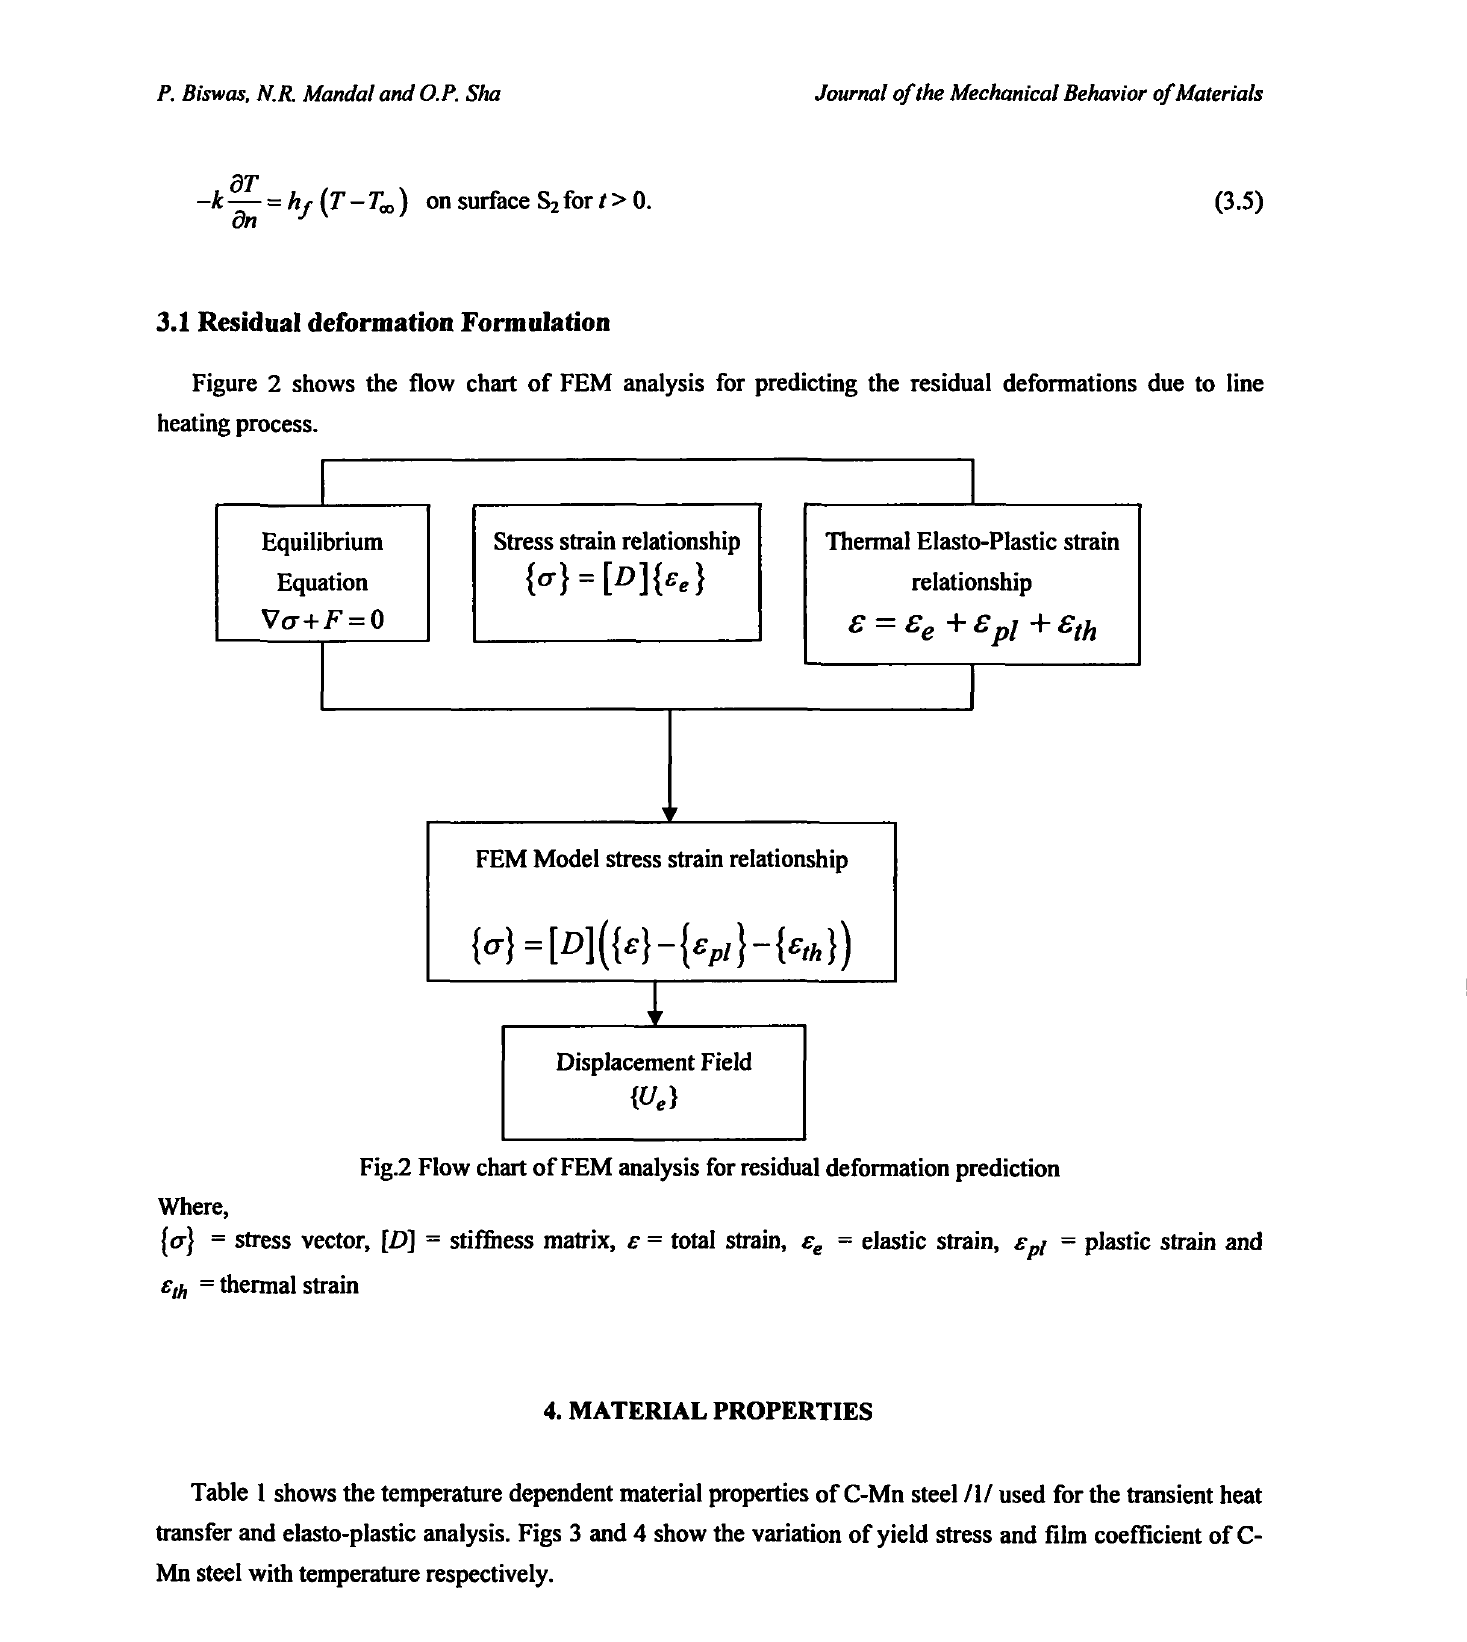
Fig.2 Flow chart of FEM analysis for residual deformation